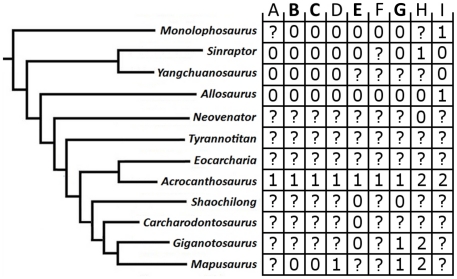
Distribution across Allosauroidea of primary and ancillary characters
diagnostic of the species Acrocanthosaurus
atokensis.Primary diagnostic characters are shown in boldface print. Refer to Appendix
S2, Appendix S3, and Table
S1 for character scorings.